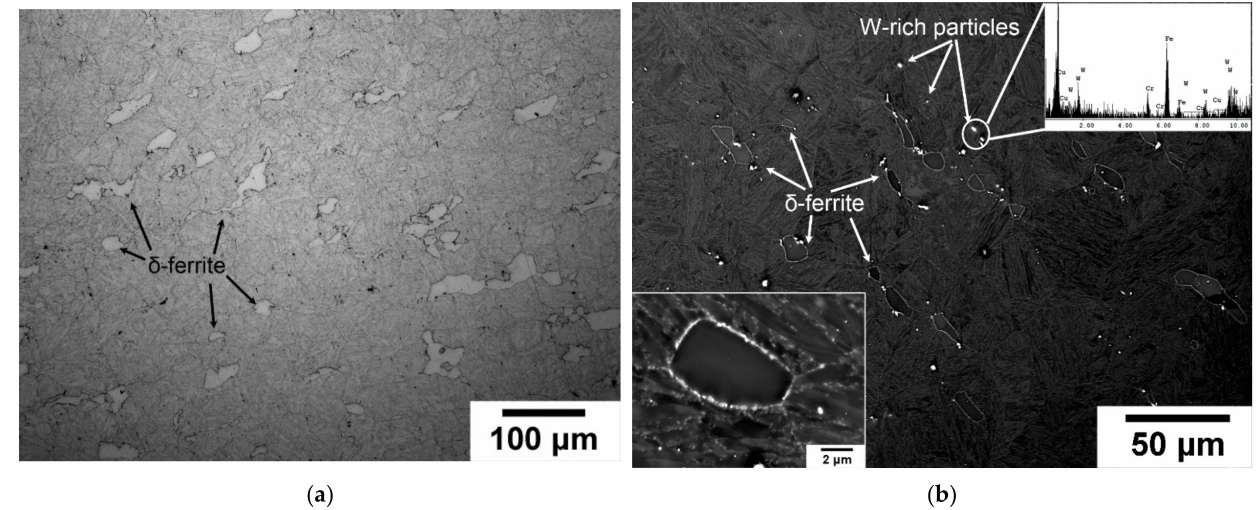
Figure 4. ( a ) Optical images of etched microstructure and ( b ) SEM image of the TMLS of the 12% Cr steel after the CHT. Table 3. Structural parameters of the 12% Cr martensitic steel after the CHT and TMP regimens. Structure Treatment